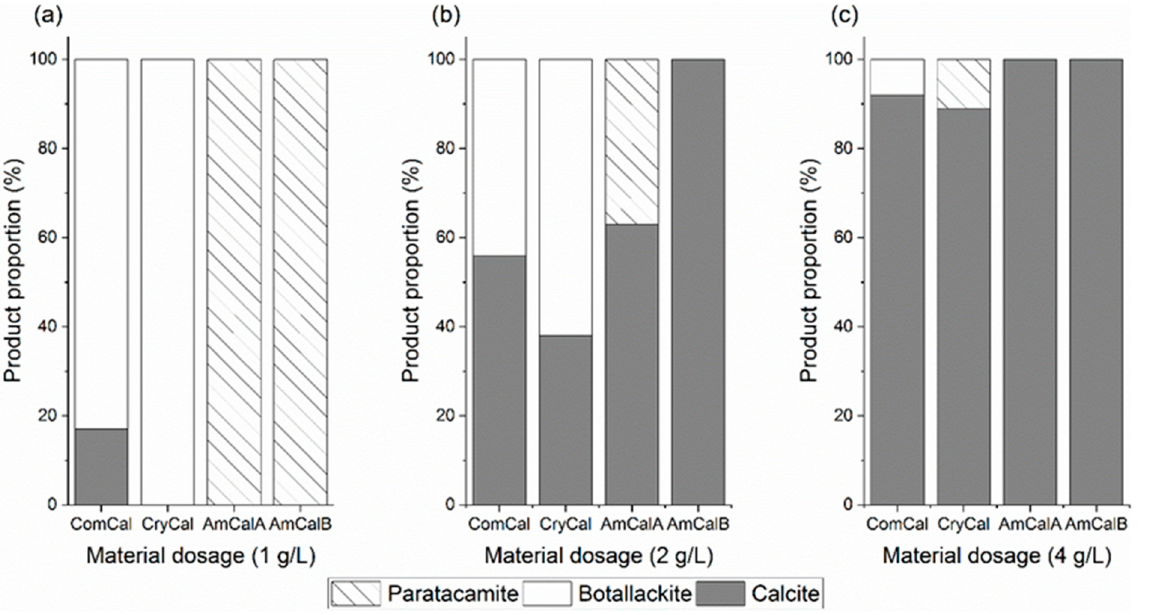
Figure 5. The mineral phases proportion of products with different material dosages. ( a ) 1 g/L, ( b ) 2 g/L and ( c ) 4 g/L.